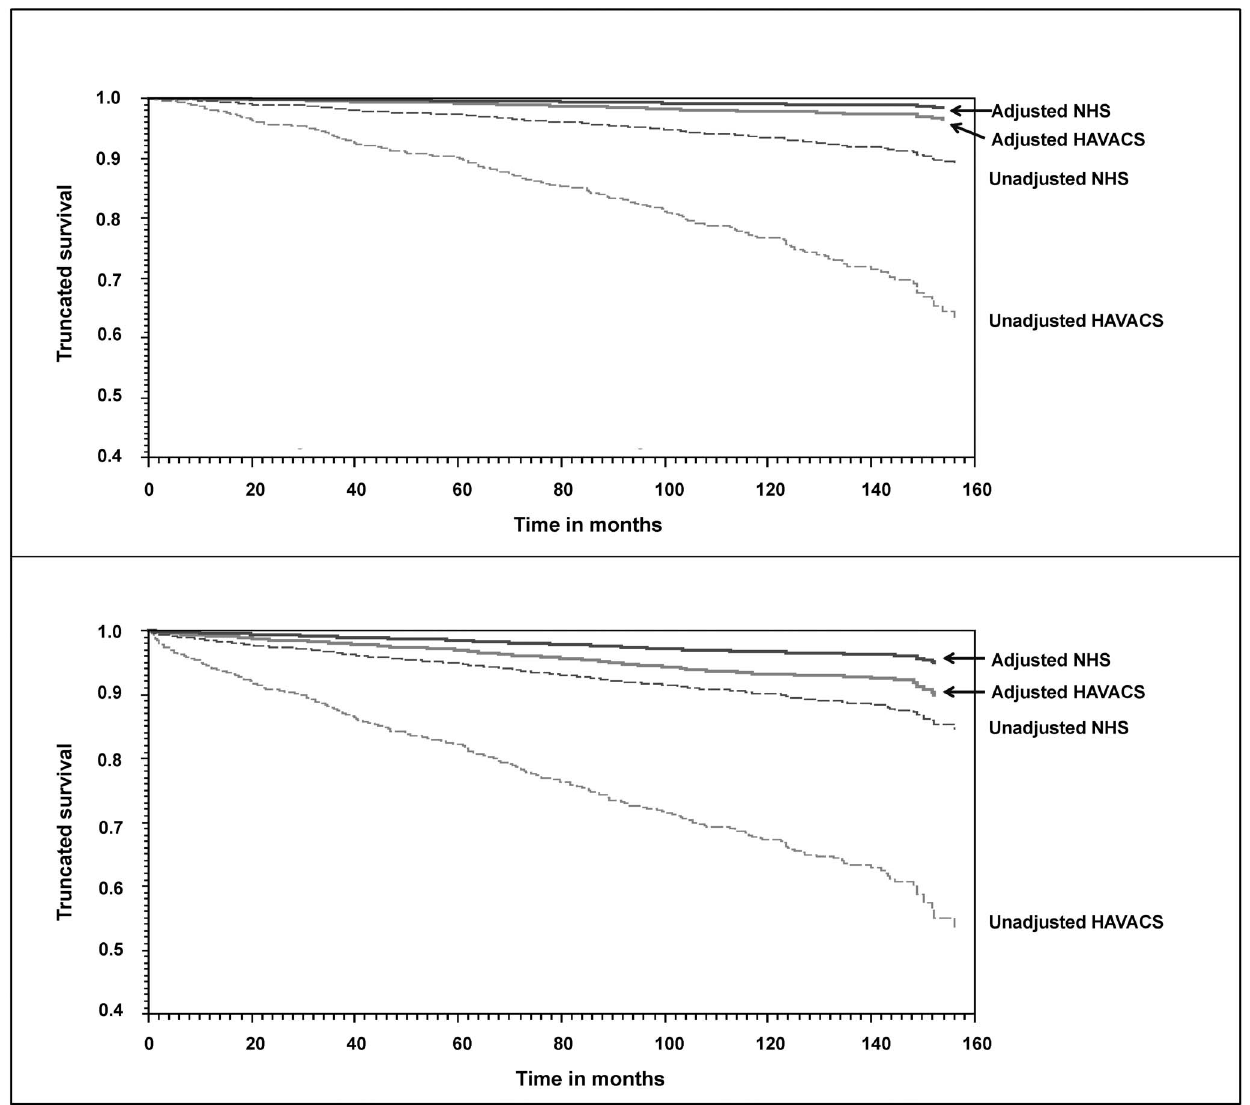
Figure 2. a. Unadjusted and adjusted survival curves from HAART initiation to death by cohort. b. Unadjusted and adjusted survival curves from HAART initiation to death or AIDS (excl. CD4 , 200) by